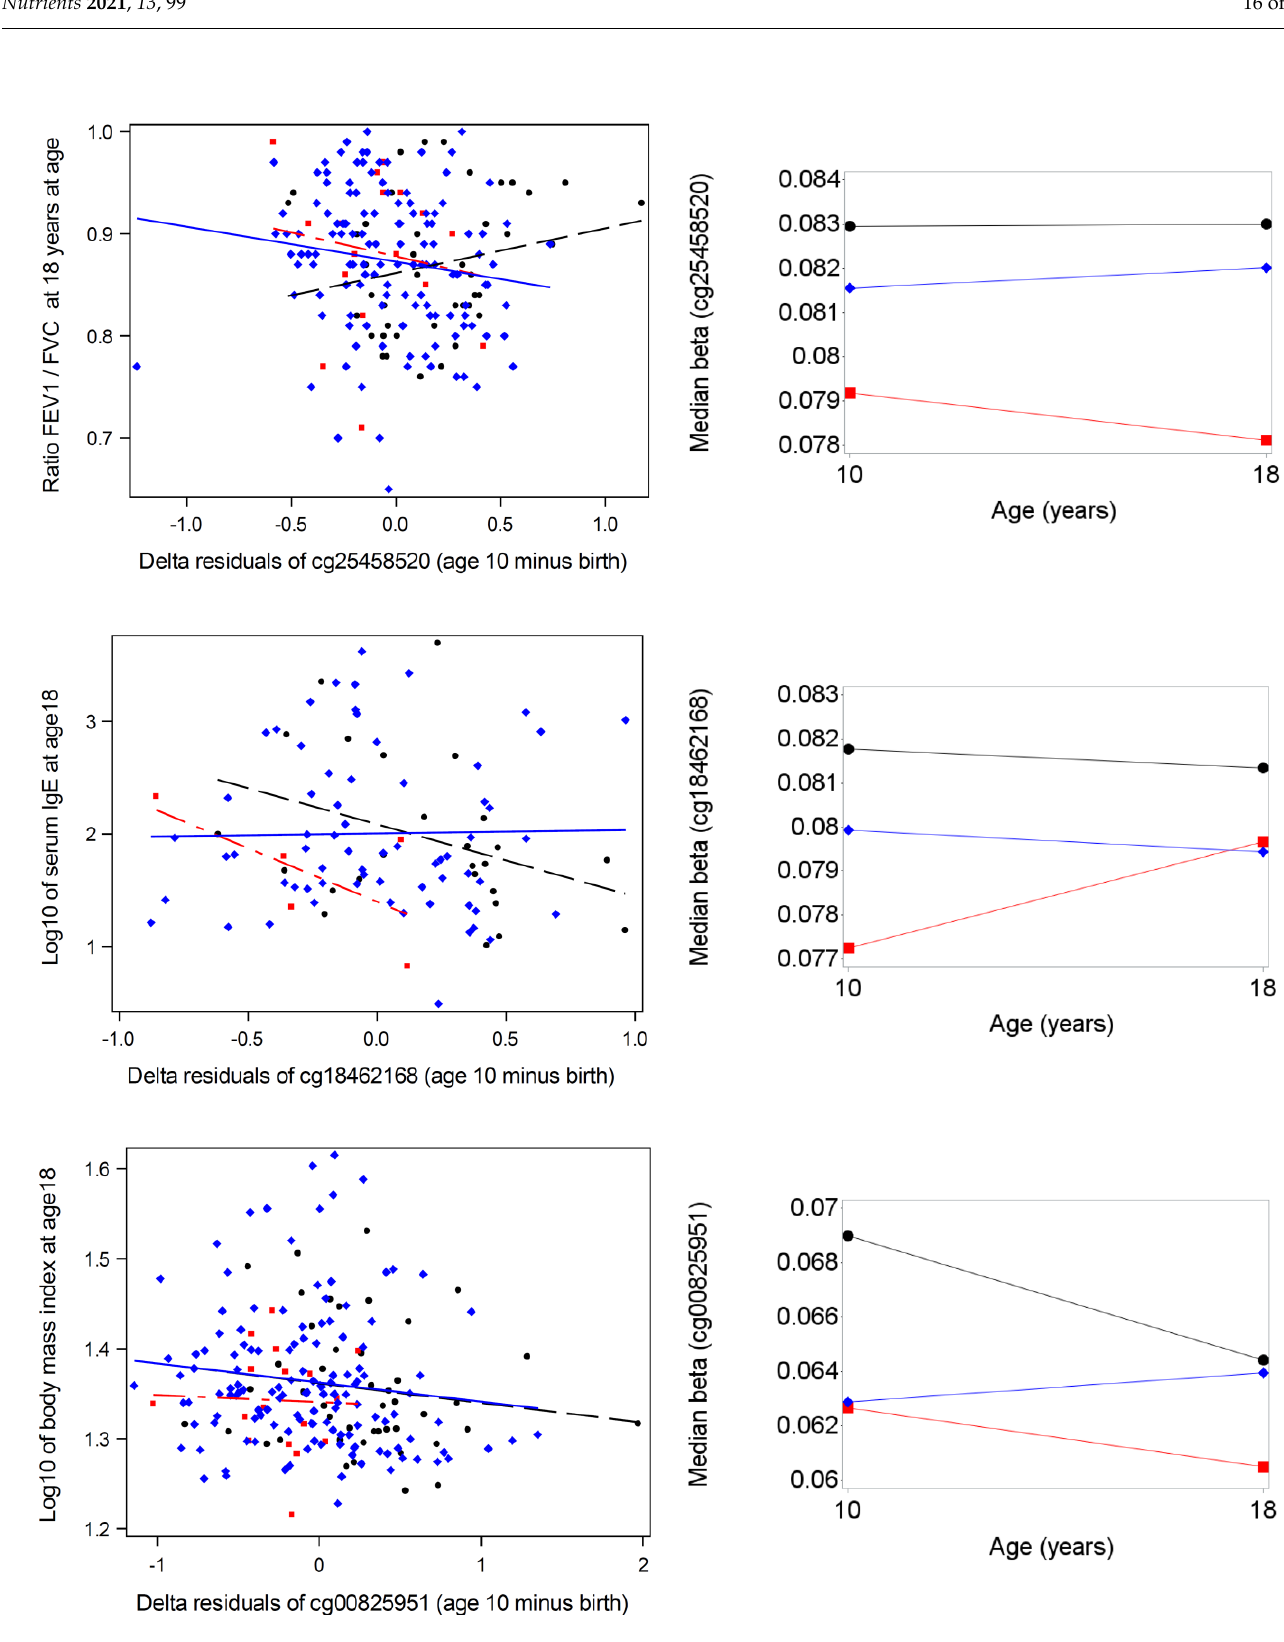
Figure 5. Scattergrams with regression lines for three different continuous health outcomes at age 18 years with delta residuals of three different CpGs and (left site) and medians of three CpGs at ages 10 and 18 years (N = 298) for three infant feeding groups: exclusive breastfeeding for 13 weeks—black, exclusive formula feeding for 13 weeks—red, mixed feeding mode—blue (right side). The ratio of forced expiratory flow in 1 s and forced vital capacity (FEV1/FVC) was based on lung function test at age 18, immunoglobulin E (IgE) was measured in serum in IU/mL, body mass index is defined as kg/m 2 .